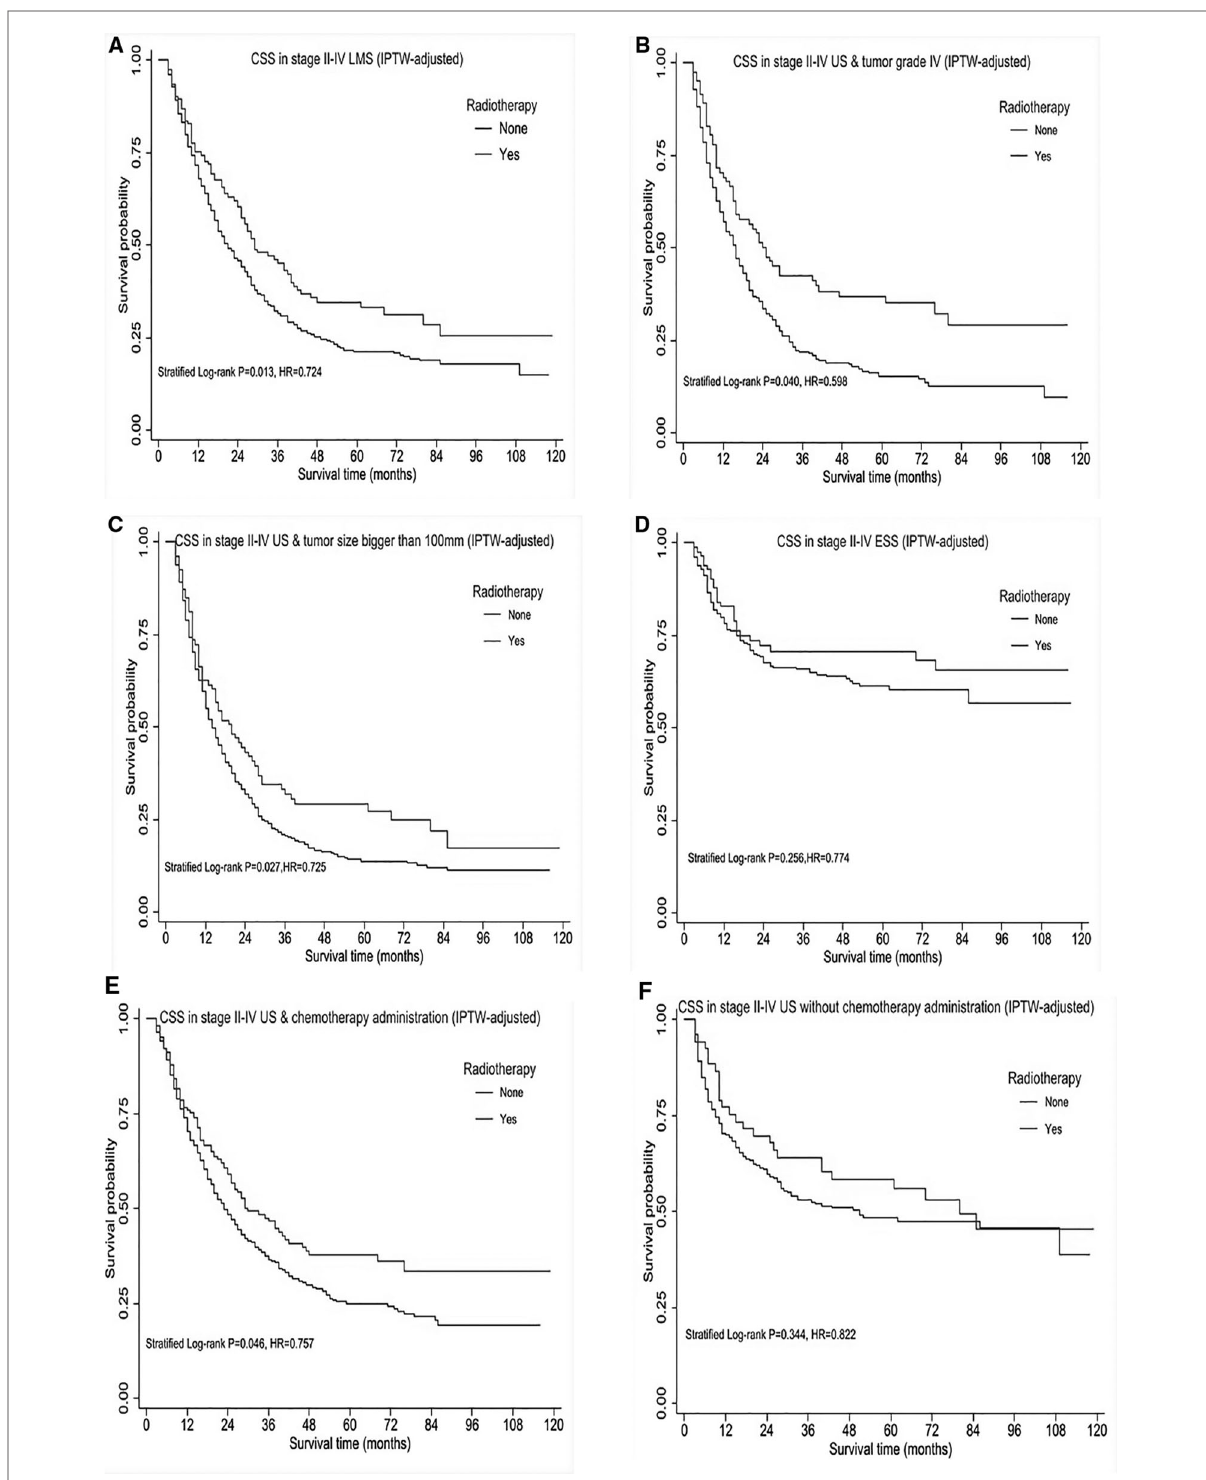
FIGURE 3 Subgroup survival analysis of cause-speci fi c survival (CSS) in stage II-IV uterine sarcomas, after IPTW-adjustment by receipt of postoperative radiotherapy. ( A ) CSS in stage II-IV uterine leiomyosarcoma. ( B ) CSS in stage II-IV uterine sarcomas with tumor grade IV. ( C ) CSS in stage II-IV uterine sarcomas with tumor size bigger than 100mm. ( D ) CSS in stage II- IV ESS across all tumor grades. ( E ) CSS in stage II- IV uterine sarcomas treated by chemotherapy with/without radiotherapy. ( F ) CSS in stage II-IV uterine sarcomas without chemotherapy administration. HR<1 favors surgery followed by radiotherapy and HR>1 favors surgery without radiotherapy administered. P <0.05 indicates statistical signi fi